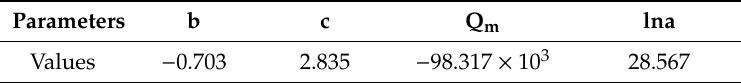
Table 2. The values of the material